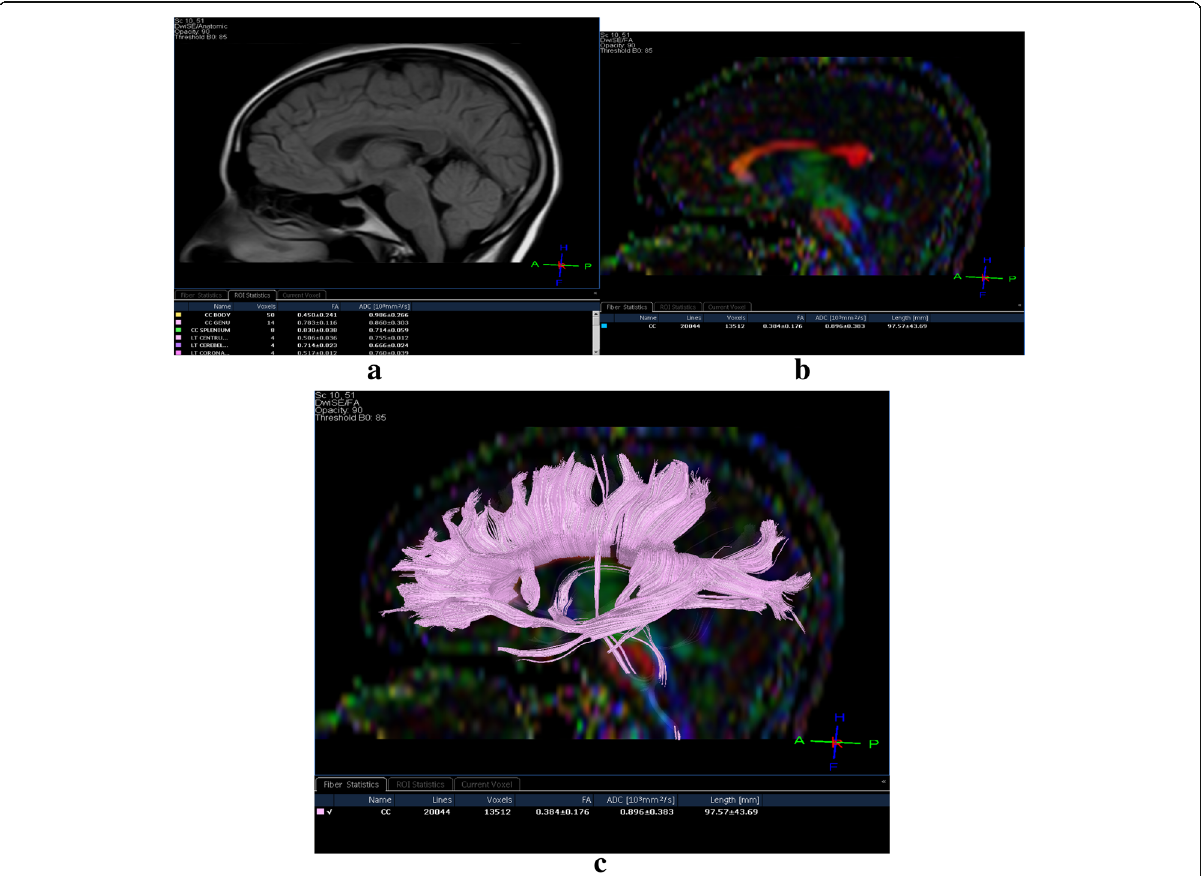
Fig. 5 Patient with RRMS. a Morphological apparently normal conventional FLAIR sagittal image of the corpus callosum. b Directionally encoded tractography color map of the same sagittal section of the corpus callosum shows a small defect in the posterior part of its body. c Tractography of the corpus callosum confirms defective fibers at the same